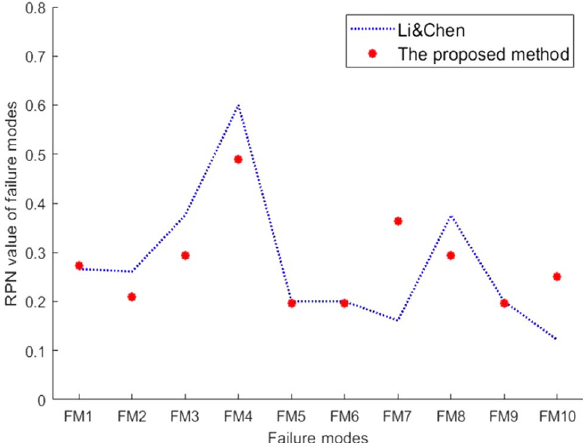
Figure 3. RPN values of Li and Chen’s method and the proposed method.